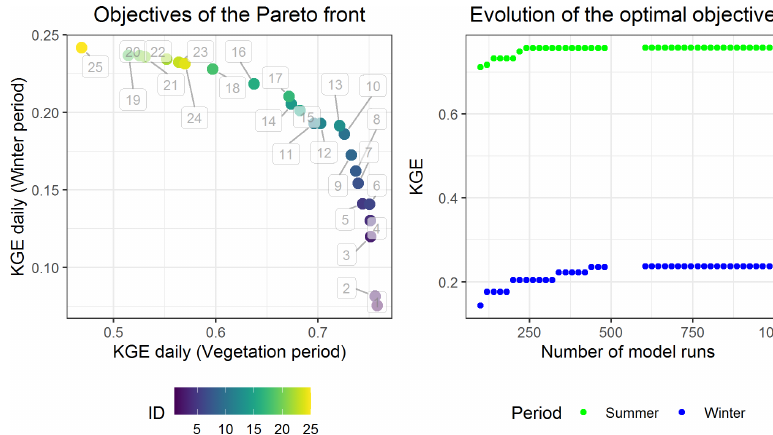
Figure C2. Resulted calibration Pareto fronts for Klingenberg (chosen ID – 13).